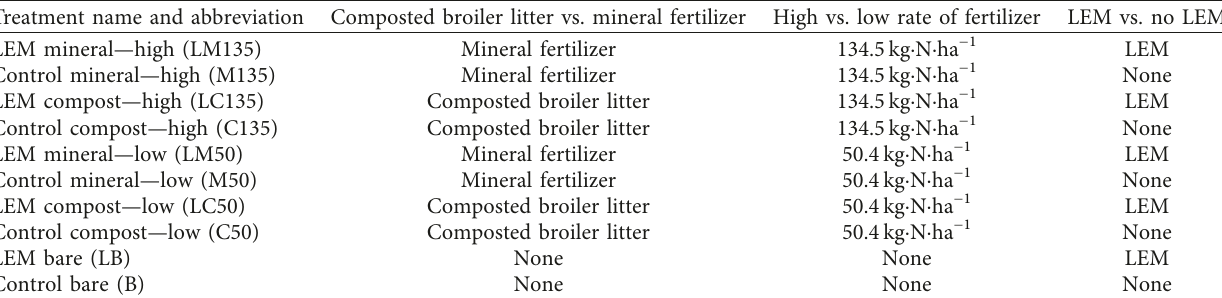
Table 1: Treatment labeling and